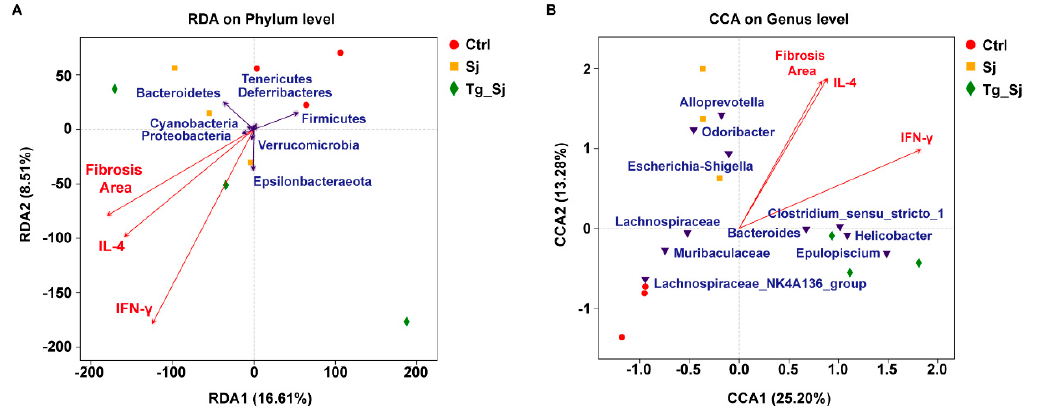
Figure 7. Redundancy analysis (RDA) and canonical correspondence analysis (CCA) based on microbial community and environmental factors. ( A ) RDA for bacterial communities at phylum level. ( B ) CCA for bacterial communities at genus level. Red arrows represented environmental variables. Polygon symbols (in red, yellow, green) and associated name represented samples. Inverted triangle (in blue) indicated the environmental factors of significant influence on bacterial communities.